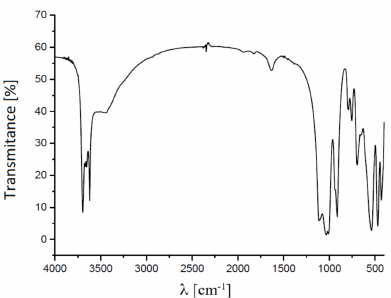
Figure 1. X-ray diffraction spectrum of kaolin particles.